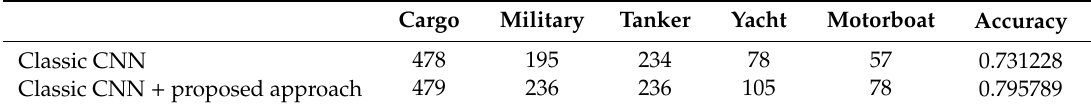
Table 6. Comparison of classic CNN usage and extended usage with the proposed